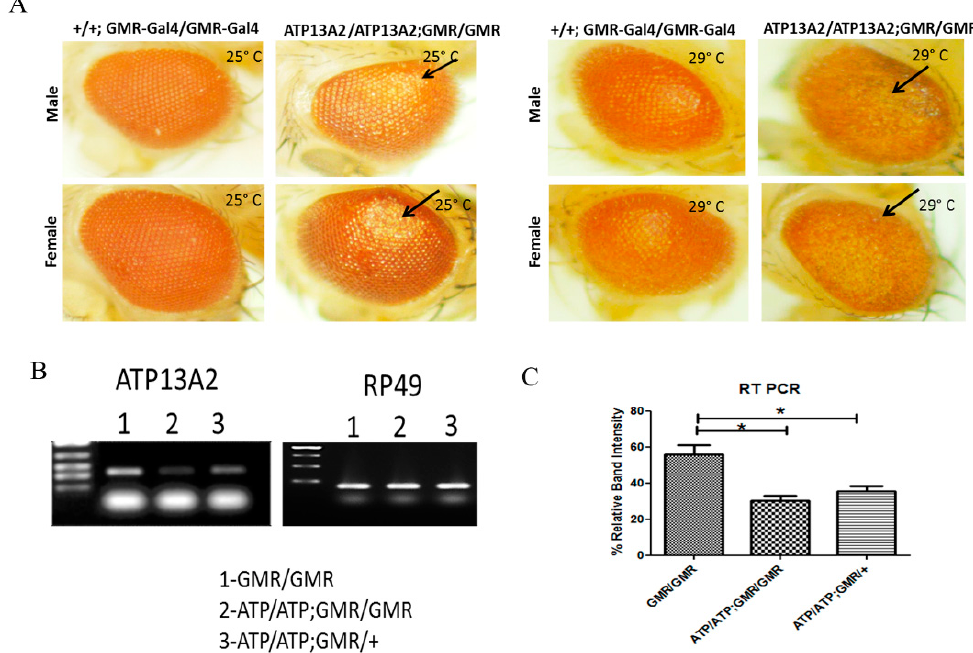
Figure 2. Targeted silencing of Drosophila ATP13A2 gene using RNAi (ATP13A2/ATP13A2). De- fective eye phenotypes observed in male and female flies maintained at 25 and 29 ◦ C carrying homologous copies of ATP13A2 RNAi with GMR-Gal4 as a driver when compared to eye phenotypes of flies with homologous copies of GMR-Gal4 alone. No gross phenotypic effect was observed in flies expressing a single copy of the GMR-Gal4 driver carrying ATP13A2 RNAi ( A ). RT-PCR confirmed significant silencing/downregulation of ATP13A2 in flies with homologous copies of ATP13A2 RNAi in the presence of GMR-GAL4 compared to the corresponding GMR-Gal4 control alone ( B ). Corresponding densitometric graph represents mean ± S. E. M for three independent experiments was shown ( C ). Differences were compared by Student’s t -test. * p <